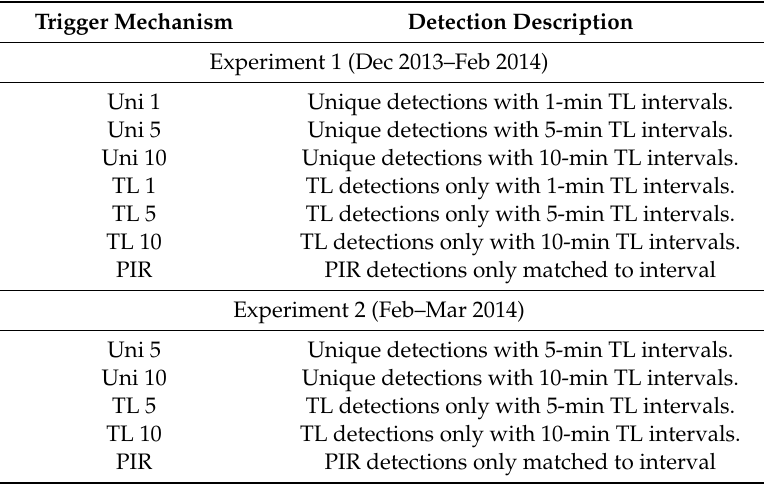
Table 1. Unique, passive infrared (PIR), and time-lapse (TL) trigger mechanism scenarios used to detect squamates during two field